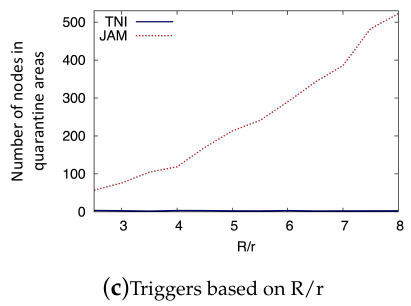
Figure 6. Nodes in Quarantine Areas by Various